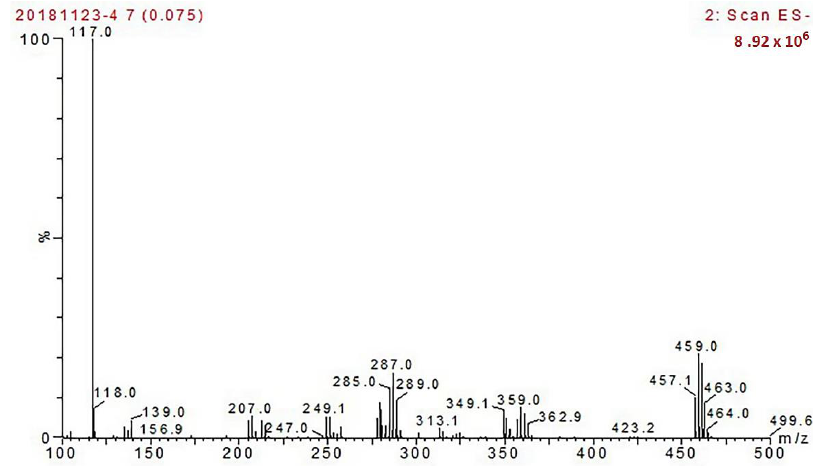
Figure 4. Identification of the endosulfan haptens by MS.